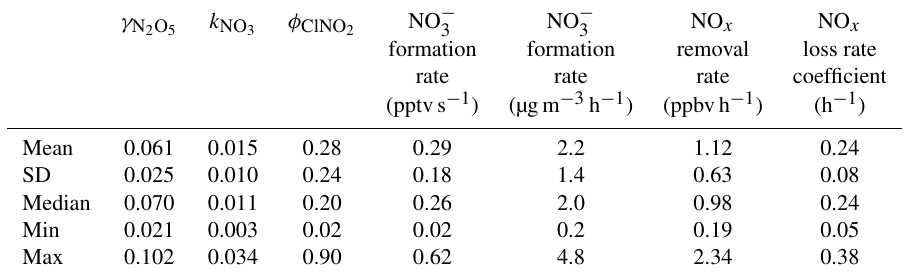
Table 2. Statistical summary of determined N 2 O 5 uptake coefficients γ , ClNO 2 yields φ , nitrate formation rates, and nocturnal NO x removal rates at Mt. Tai during the study